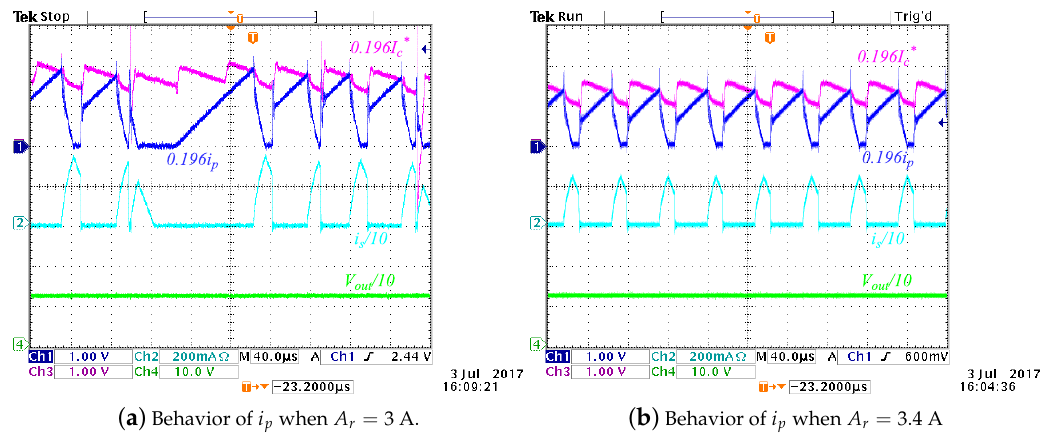
Figure 9. Experimental results with two different values of the compensation ramp for V ref = 120